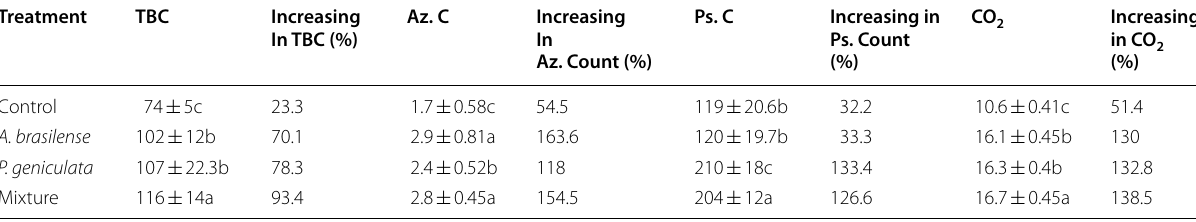
Table 1 Microbiological characteristics of Flax ( Linum usitatissimum ) rhizosphere at the